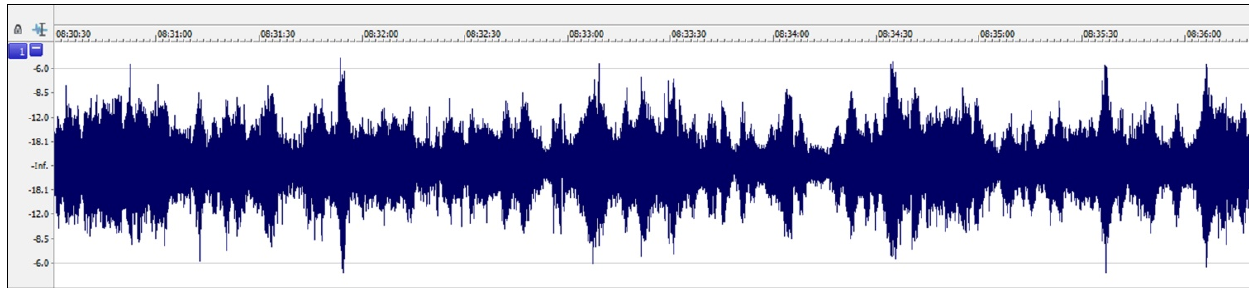
Figure 7 . Soundscape map (detail), 8:30 a.m.–8:36a.m., 23 August 2013 (53°18'10.1"N 2°58'00.9"W).To listen to soundscape see: [43] (recording best heard with